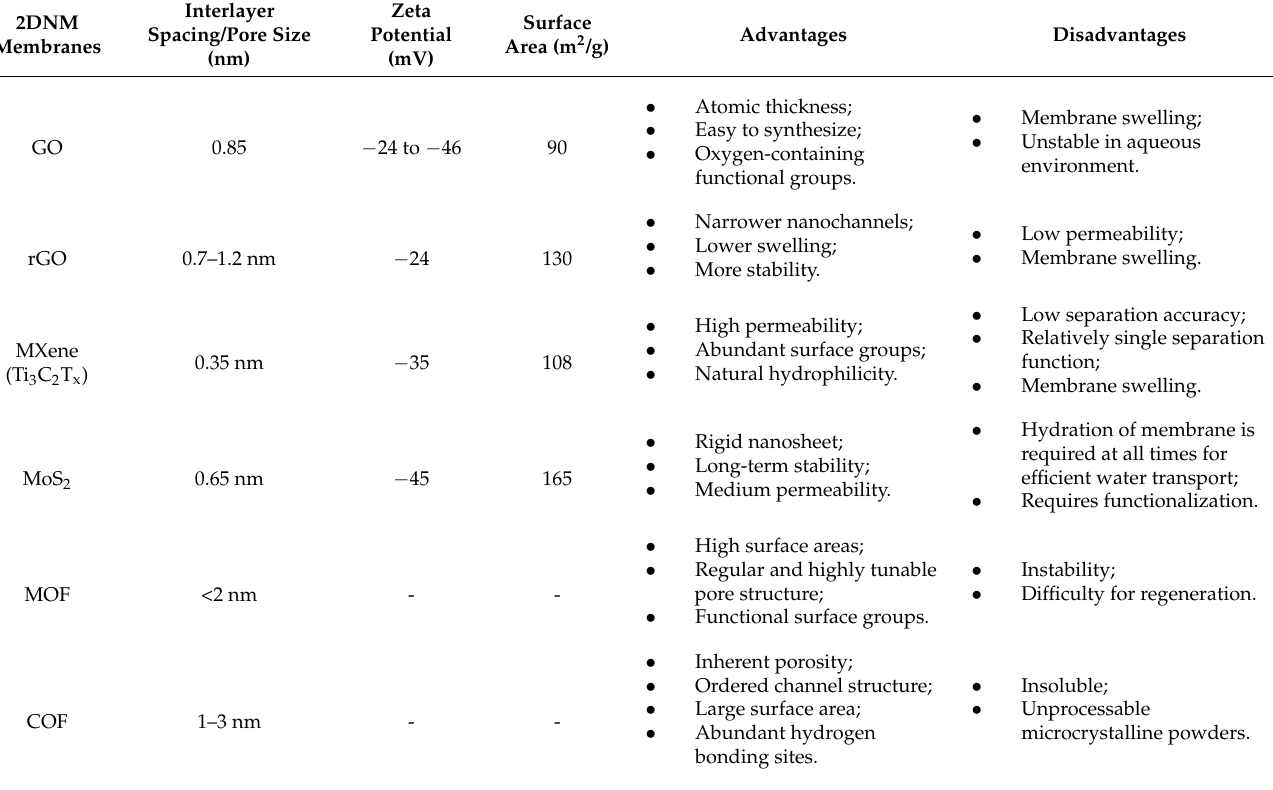
Table 1. Comparison of properties of 2D material membranes and their advantages and disadvantages in water